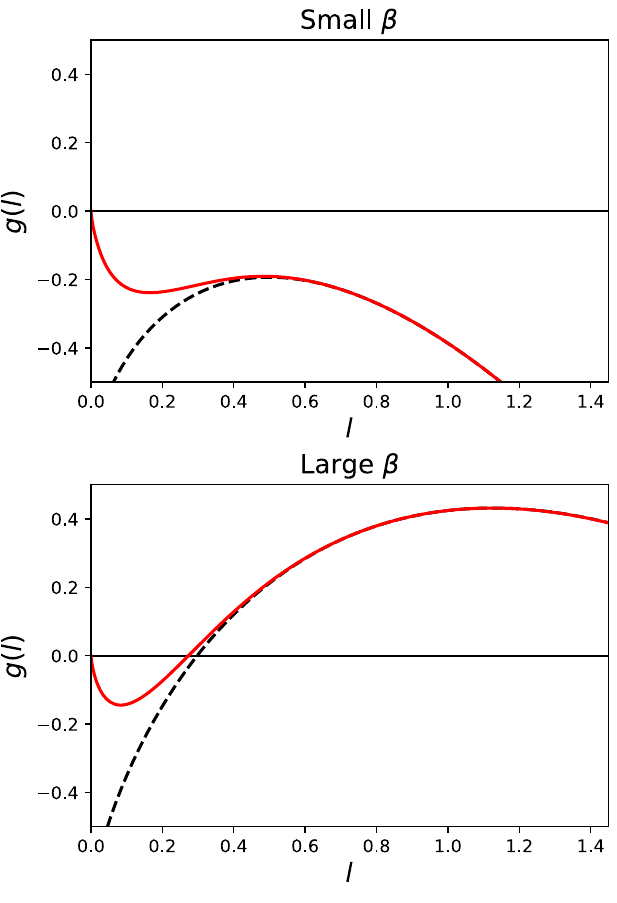
FIG. 2. The exponent g ð l Þ governing corrections to the an- nealed free energy, for both small β and large β . Dashed lines are the asymptotic behavior of g ð l Þ at large l . The specific parameters used are p ¼ 6 , small β ¼ 1 . 0 , large β ¼ 1 . 5